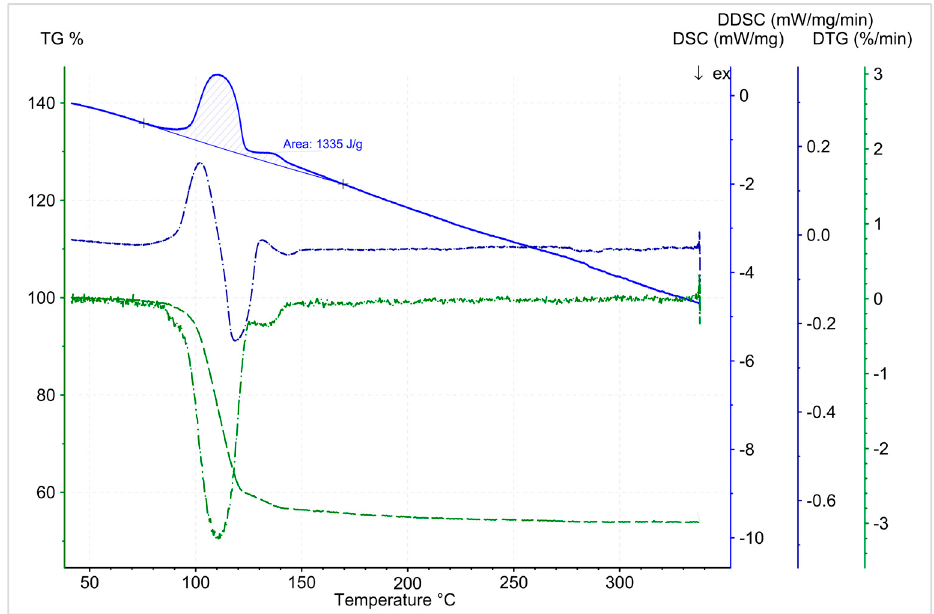
Figure 13. Temperature-dependent dehydration start of 2 mg H 3 BO 3 at a heating rate of 2 °C/min (TG, DSC, DTG, DDSC). Specific energy content of the reaction: 1.3 KJ/g.